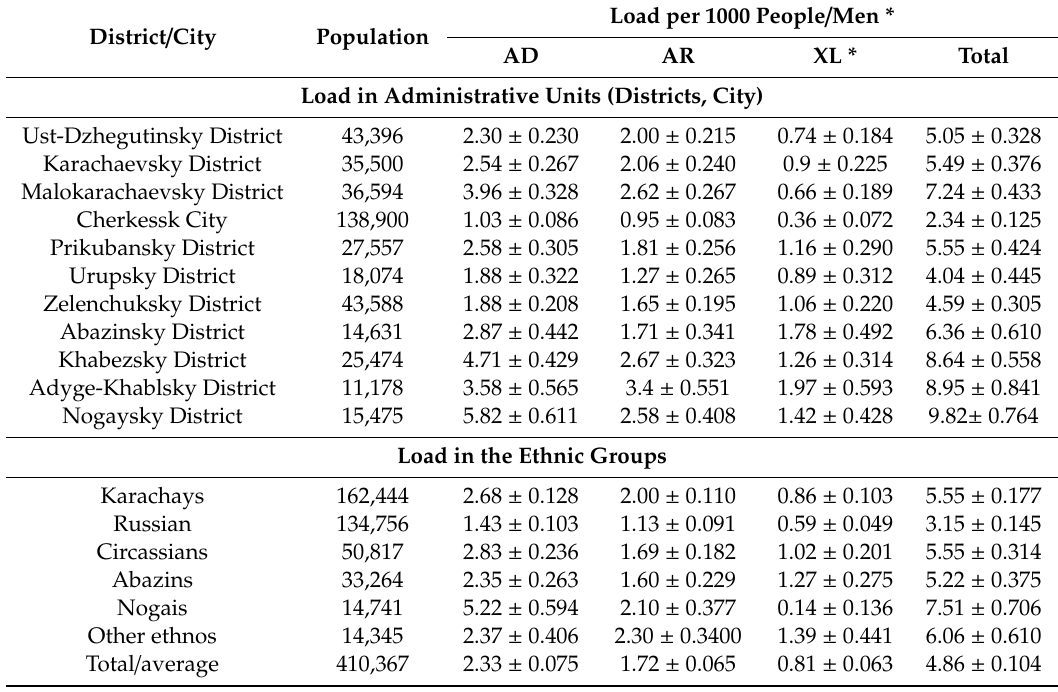
Table 2. The genetic load of HD (per 1000 examined) in the populations of Karachay-Cherkess Republic